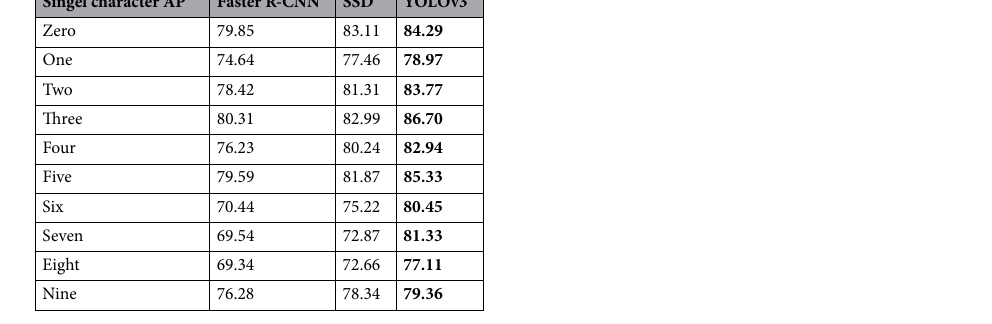
Table 11. Experimental results of Plan A. The bold values are meant to represent the best results obtained under the corresponding metric.